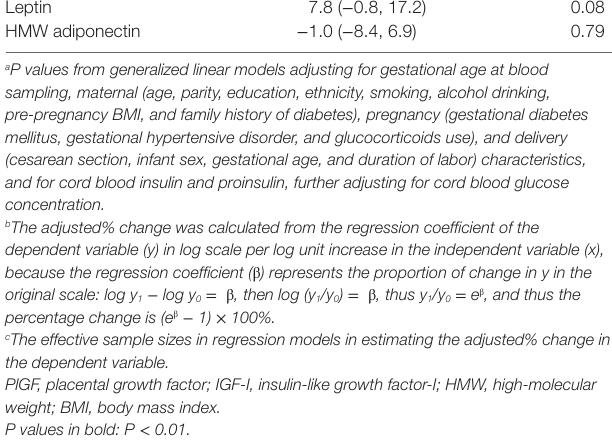
weight; BMI, body mass index. P values in bold: P < 0.01.